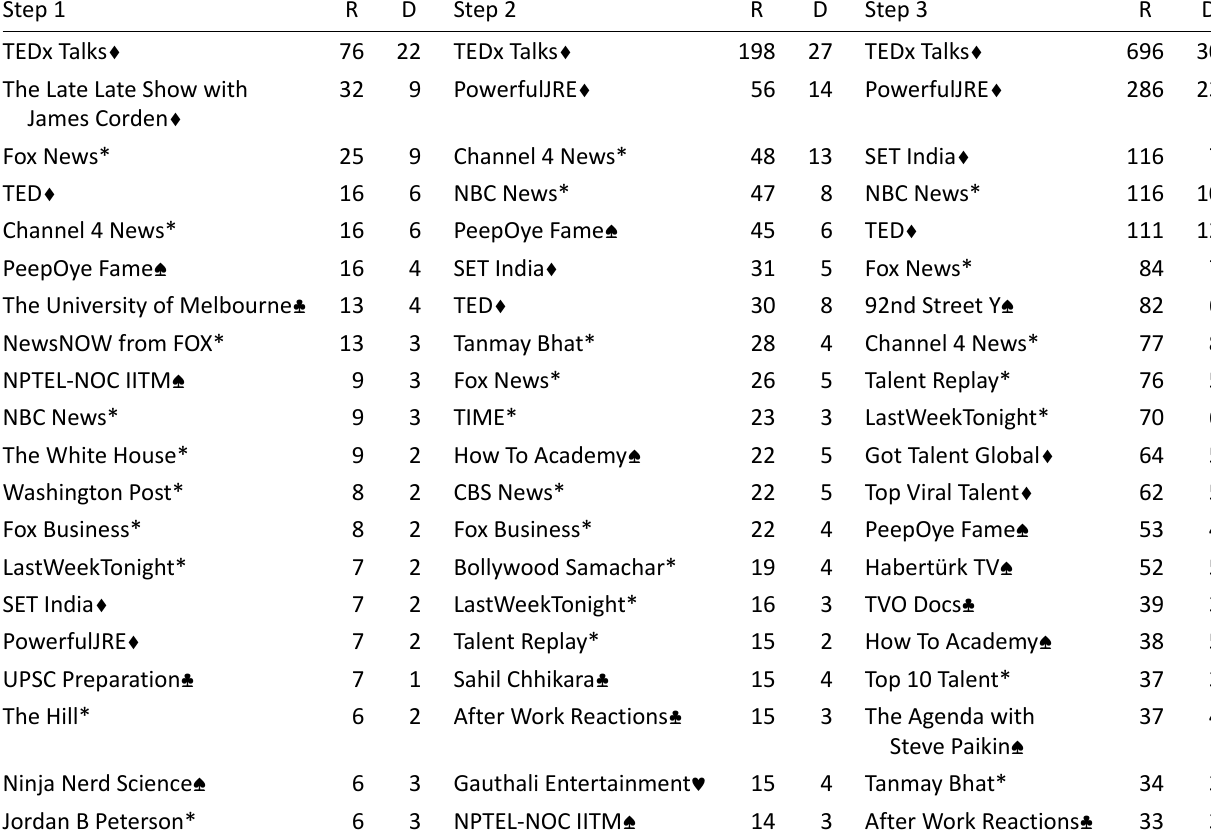
Table 3. Top 20 channels recommended for “feminism” at each step. Step